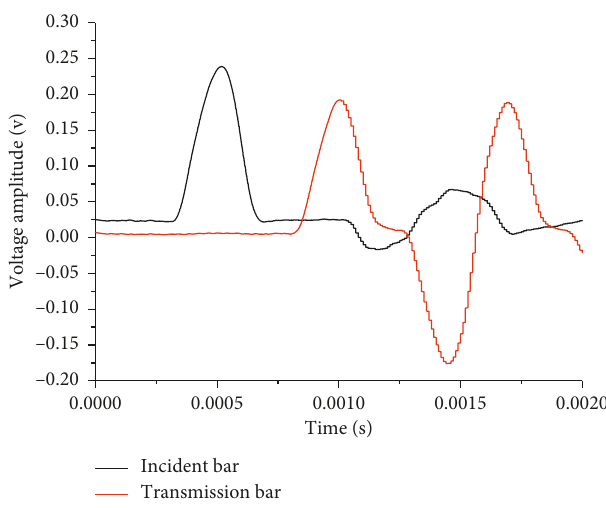
Figure 3: Signal diagram for specimen #6 under dynamic